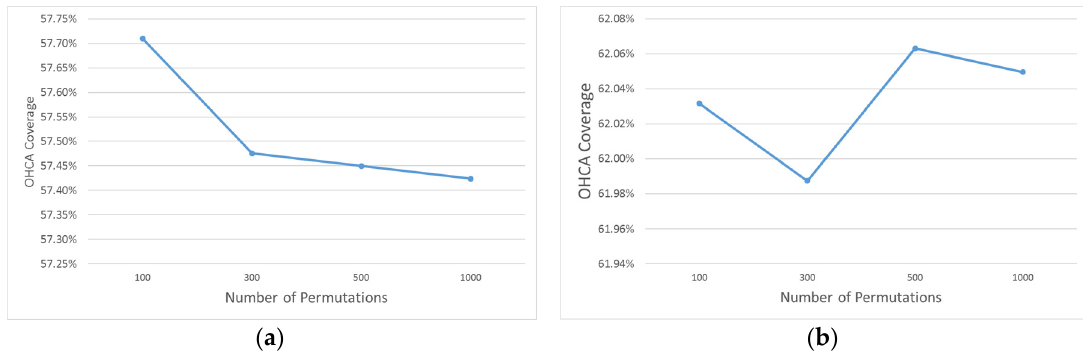
Figure 12. Coverage ratio in terms of the number of permutations for all OHCA cases. ( a ) Grid-based coverage. ( b ) Network junction-based coverage.